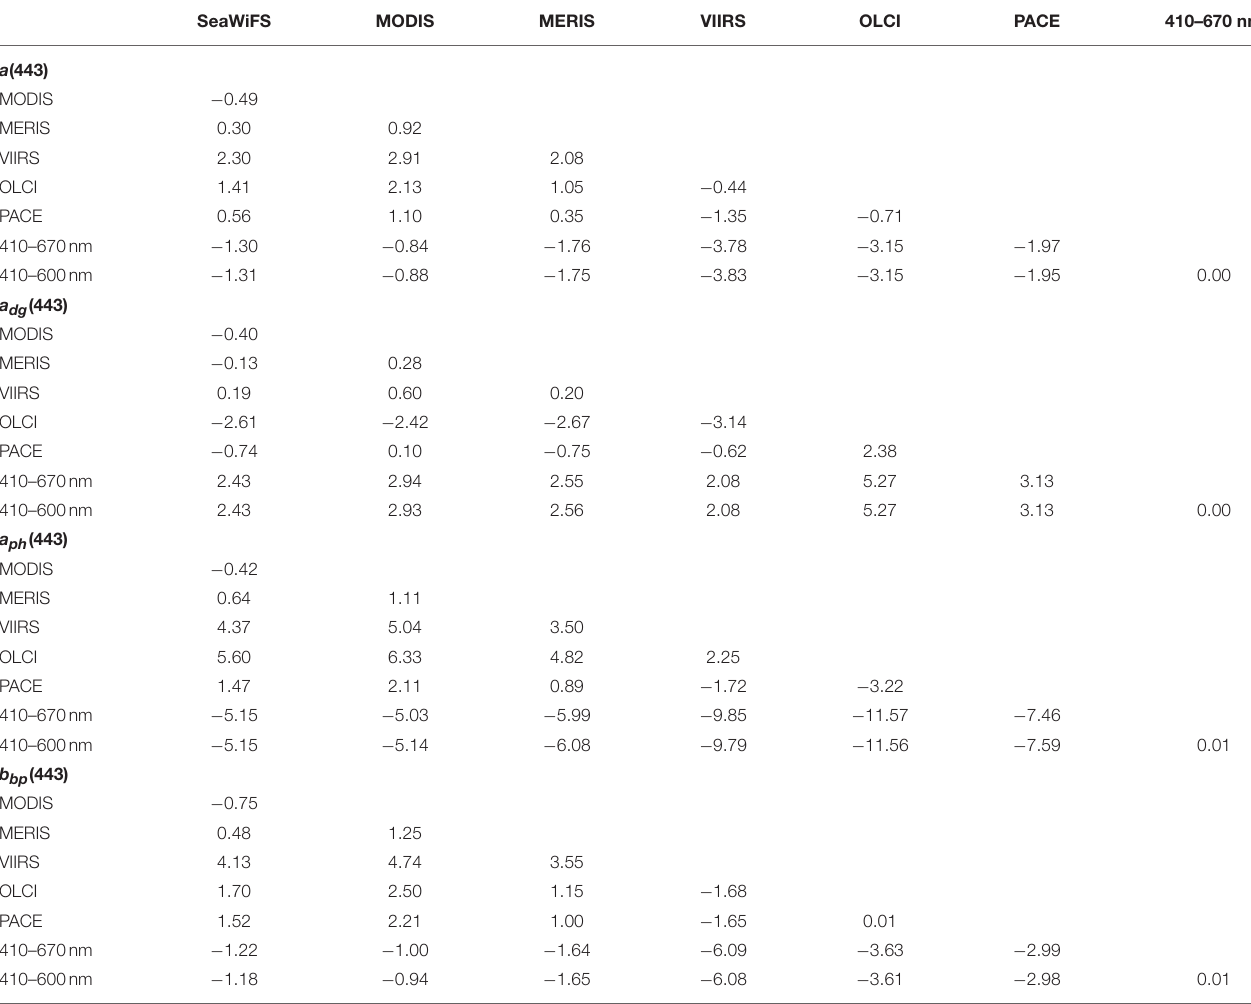
TABLE 2 | Satellite-to-satellite median UPD for IOPs at 443nm for oligotrophic water ( C a ≤ 0.1mg m − 3 ). Relative to Equation (7), columns represent satellite 1 and rows represent satellite 2 (e.g., MODIS a (443) is 0.49% lower (thus, negative) on average than that for